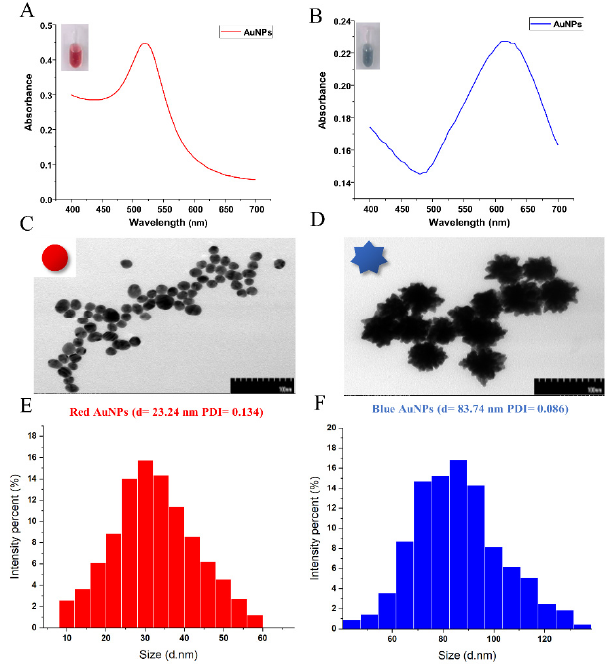
Figure 1. Characterisation of the optical properties, shapes and sizes of red and blue AuNPs. ( A , B ) UV–vis absorption spectra of two-colour AuNPs. Inset: the relevant photographic images of the synthesised AuNP solution. ( C , D ) TEM images. Inset: the structural diagrammatic presentation of synthesised AuNPs. ( E , F ) Hydrodynamic diameter. PDI indicates the polydispersity index.